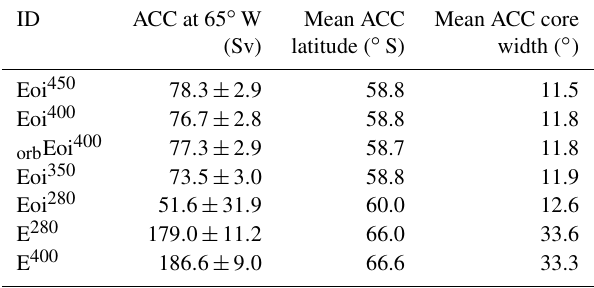
Table 8. Characteristics of the Antarctic Circumpolar Current (ACC) within the Pliocene and pre-industrial experiments. From the barotropic streamfunction, we derive the mean ACC latitude (the polar front) from the centroid of the zonal transport and the core width from the ± 50%